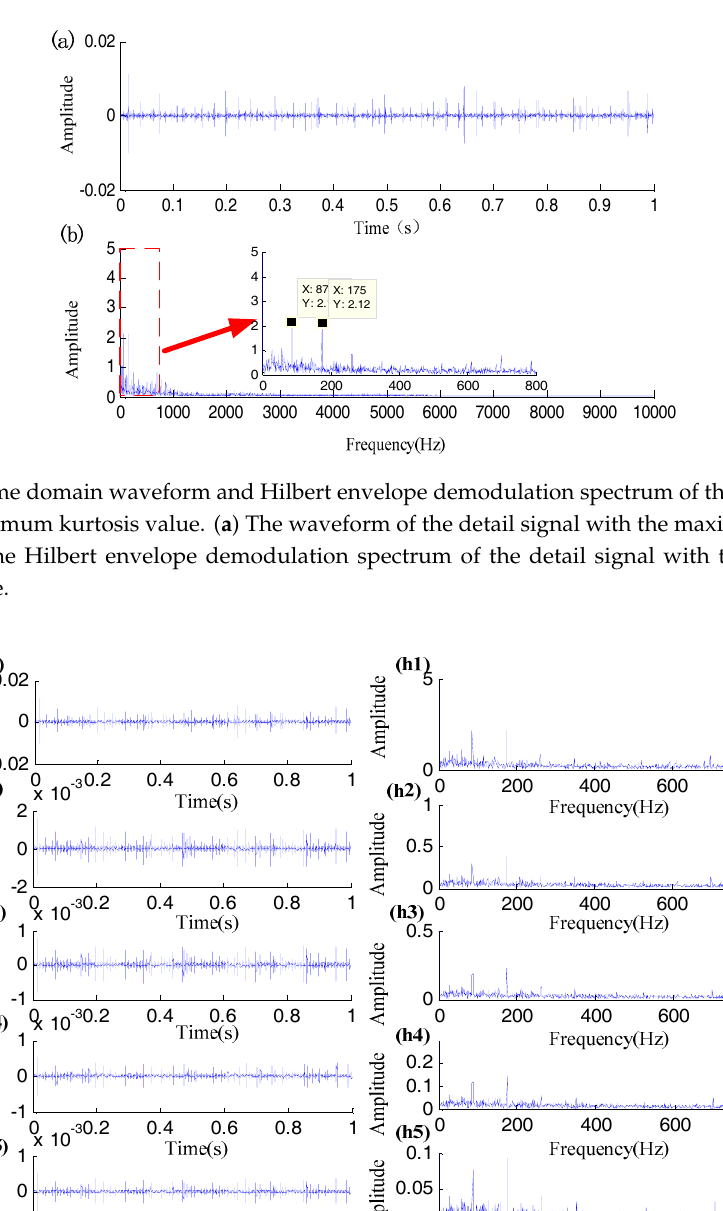
Figure 12. Time domain waveform and Hilbert envelope demodulation spectrum of the detail signal with the maximum kurtosis value. (a) The waveform of the detail signal with the maximum kurtosis value. (b) The Hilbert envelope demodulation spectrum of the detail signal with the maximum kurtosis value.